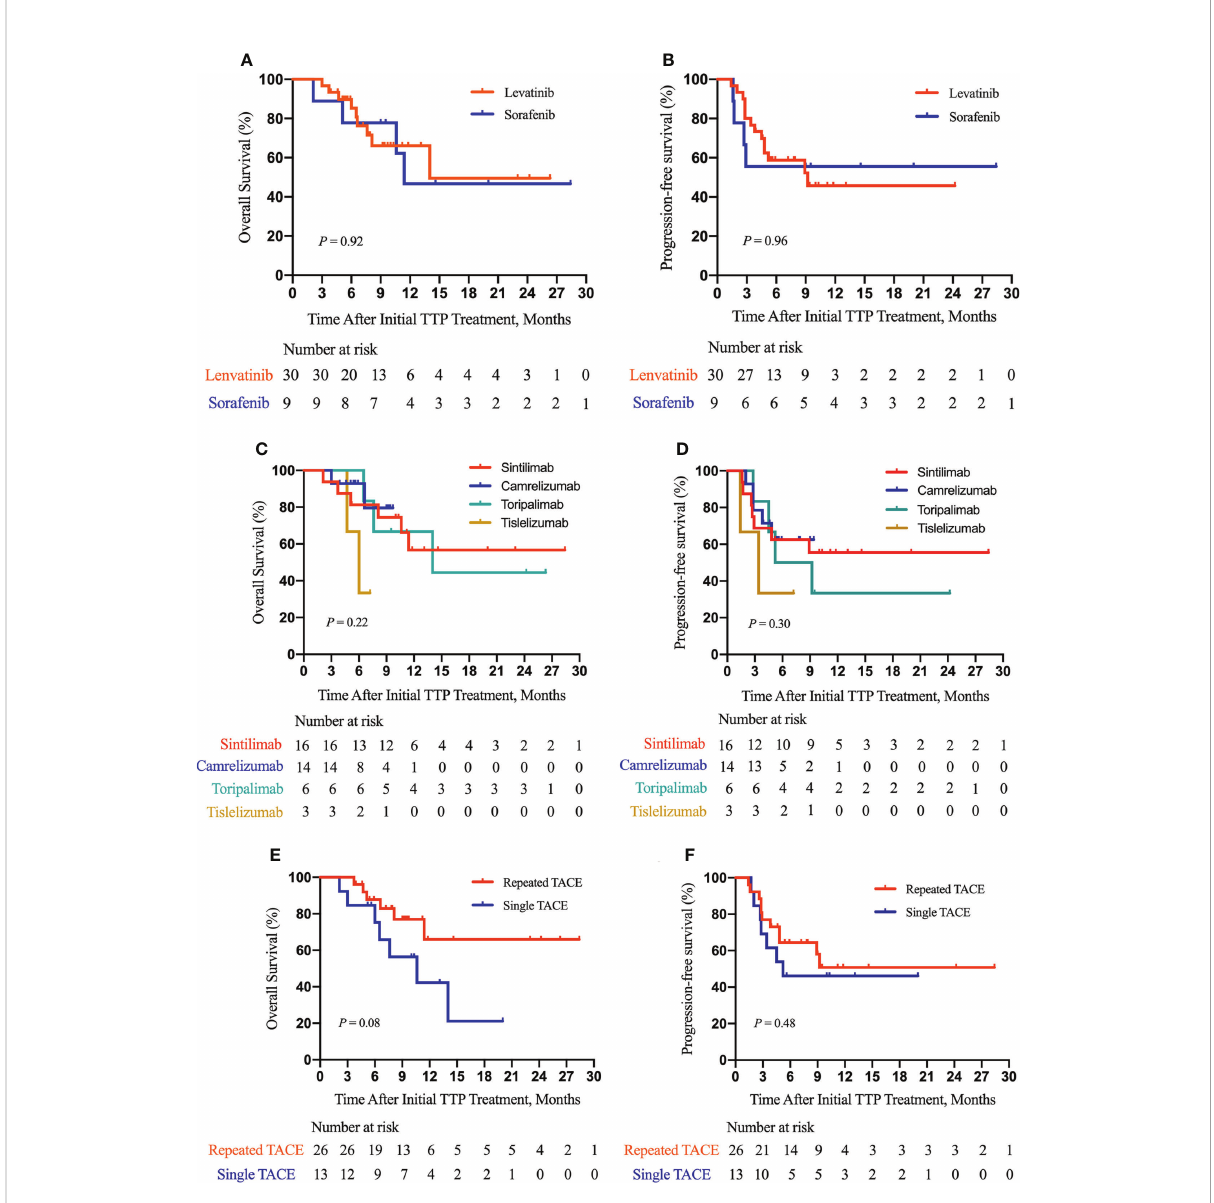
FIGURE 3 Subgroup survival analysis according to the type of molecular targeted drugs, the type of PD-1 inhibitors, and the number of TACE procedures. Subgroup analysis of OS (A) and PFS (B) according to the type of molecular targeted drugs; a subgroup analysis of OS (C) and PFS (D) according to the type of PD-1 inhibitors; a subgroup analysis of OS (E) and PFS (F) according to the number of TACE procedures. TTP, TACE plus antiangiogenic-targeted treatment and anti-PD-1 inhibitors; TACE, transarterial